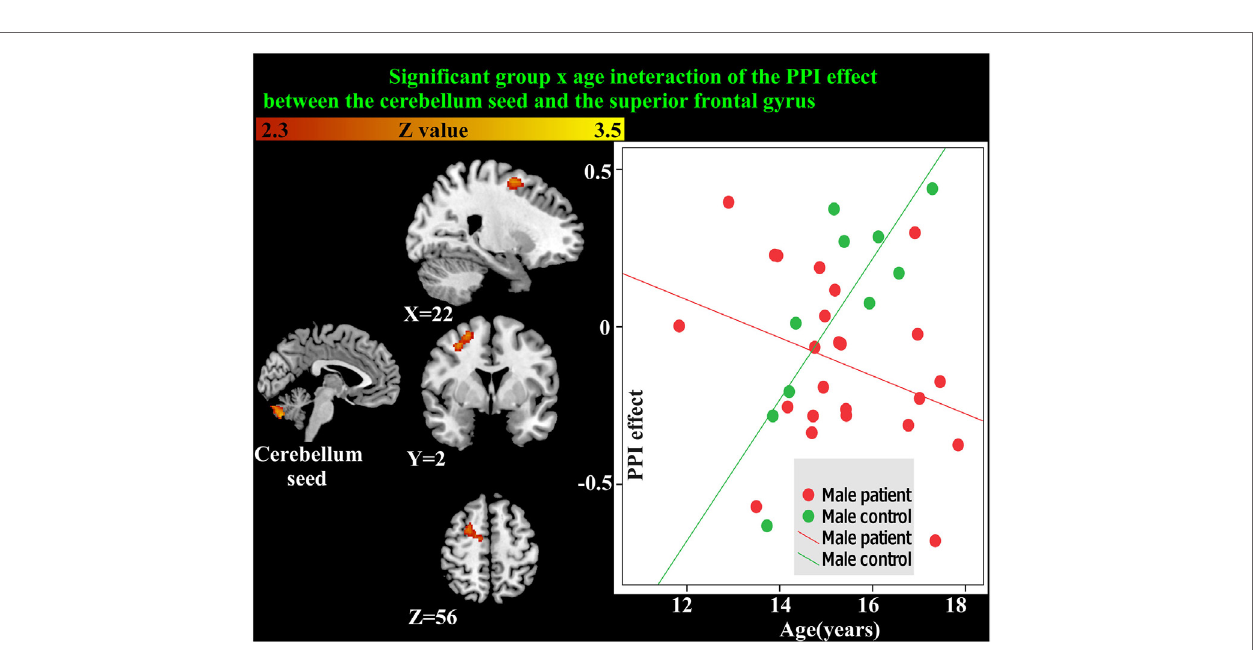
FigUre 5 | Significant group × age interaction of the psychophysiological interaction (PPI) connectivity between the cerebellum seed and superior frontal gyrus is shown. With age, connectivity increases in strength in male controls but decreases in strength in males with major depressive